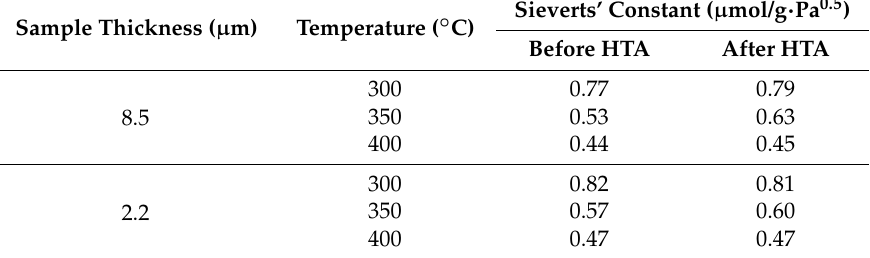
Table 2. Sieverts’ constant measured at different temperature for 2.2 µ m and 8.5 µ m thick membranes before and after heat treatment in air.